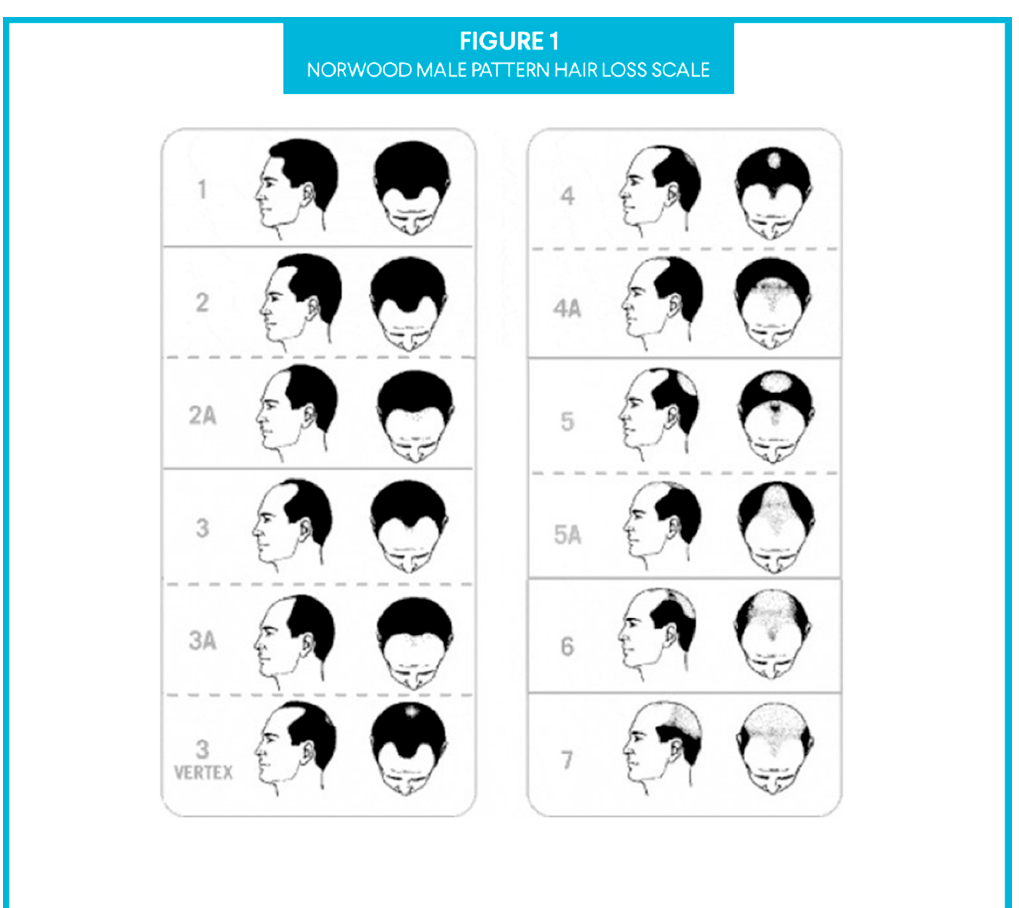
Figure 1. Male androgenetic alopecia